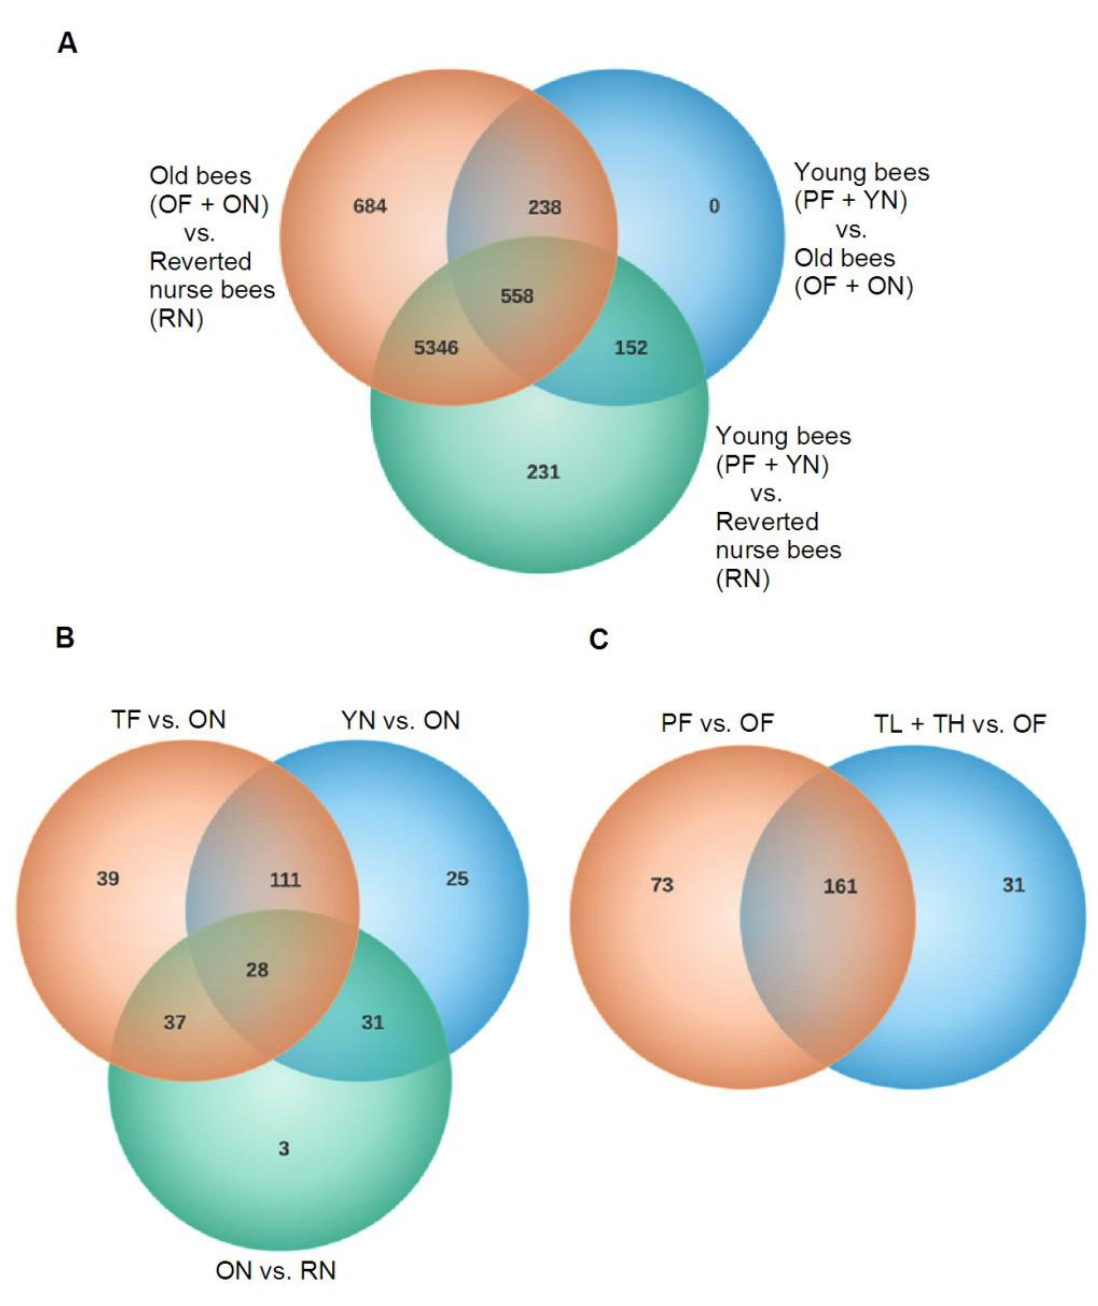
Figure 3. Unique and shared transcripts. Venn diagrams were used to visualize transcripts unique and shared between each group. Numbers represent transcripts differentially expressed (FDR < 0.05). ( A ) Transcripts differentially expressed between young bees, old bees and reverted nurse bees. ( B ) Transcripts differentially expressed between nurse bees. ( C ) Transcripts differentially expressed between forager bees. YN = young nurse (8 (cid:177) 10 days-old; <1 day flight); RN = reverted nurse (25 (cid:177) 26 days-old; 7 (cid:177) 9 days flight); OF = old forager (25 (cid:177) 26 days-old; 10 (cid:177) 12 days flight); TH = typical-aged forager-high flight (19 (cid:177) 22 days old; 7 (cid:177) 9 days flight); ON = older nurse (19 (cid:177) 22 days old; <1 day flight); TL = typical-aged forager-low flight (19 (cid:177) 22 days old; 2 (cid:177) 3 days flight); PF = precocious forager (8 (cid:177) 10 days old; 2 (cid:177) 3 days